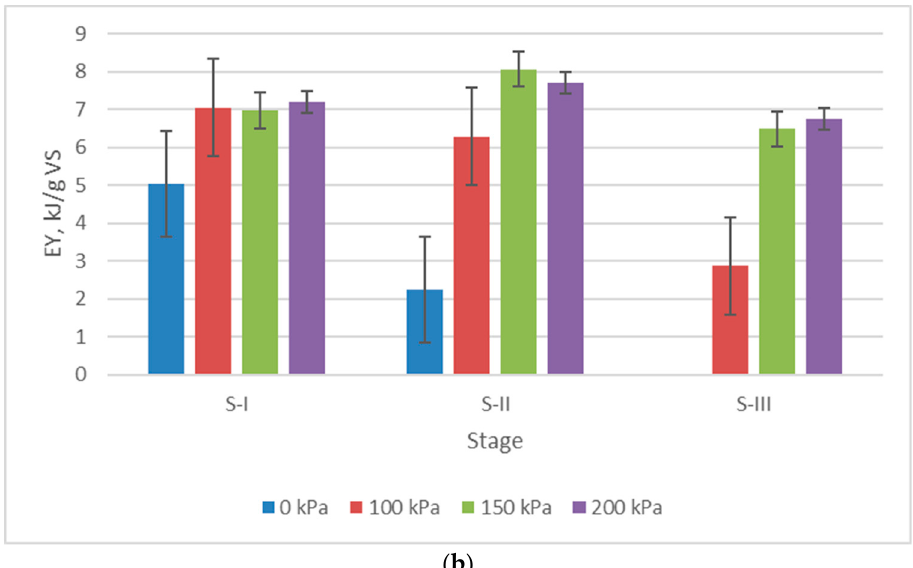
Figure 8. Average values of energy production rate (EPR) ( a ) and energy yield (EY) ( b ) depending on the overpressure and HRT in the digesters.